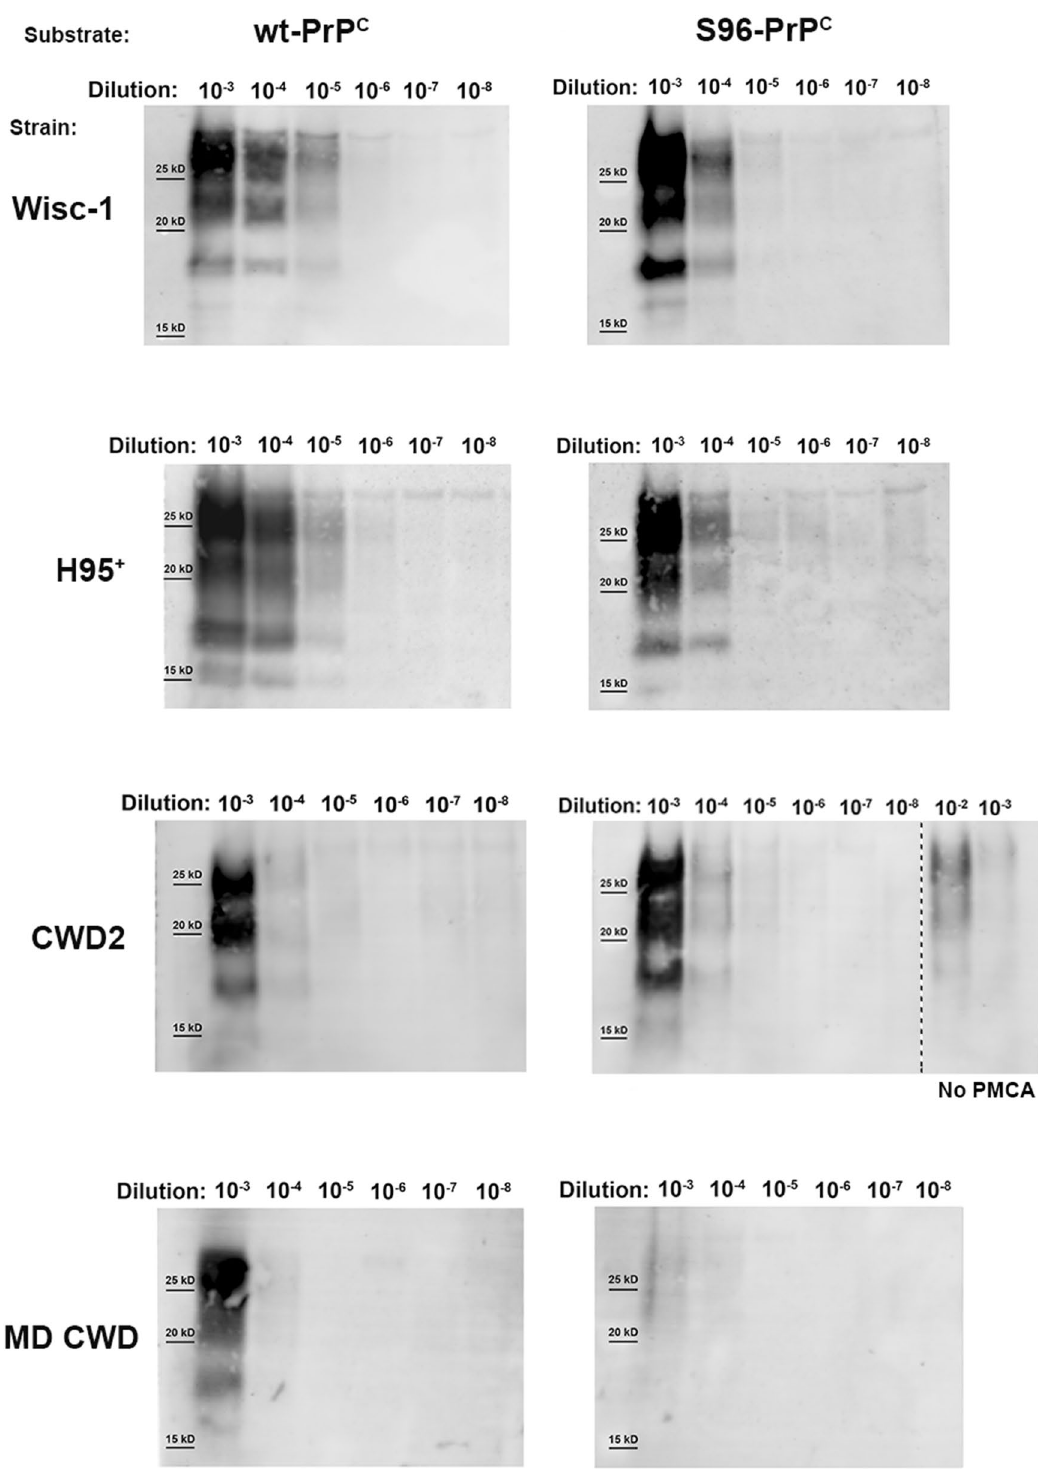
Figure 1. PMCA amplification efficiency of different CWD isolates in wild-type (wt) and S96-PrP C substrates. Serial dilutions (10 −3 to 10 −8 ) of white-tailed deer CWD strains Wisc1 and H95 + , CWD2 strain from elk and a CWD isolate from a naturally infected mule deer (MD) were subjected to PMCA in wt-PrP C or S96-PrP C brain homogenate substrates (tg33 and tg60 mouse brain homogenates, respectively). PMCA products were digested with PK (50 µg/ml) and analyzed by western blot. Wisc-1 and H95 + strains propagated more efficiently in the wt-PrP C substrate. CWD2 strain propagated with the same efficiency in both wt and S96-PrP C substrates. A 10 -2 and a 10 -3 dilution of the CWD2 strain in brain homogenate, not subjected to PMCA, is shown as a control of PMCA amplification. MD CWD only propagated in the substrate expressing wt-PrP C . mAb Sha31